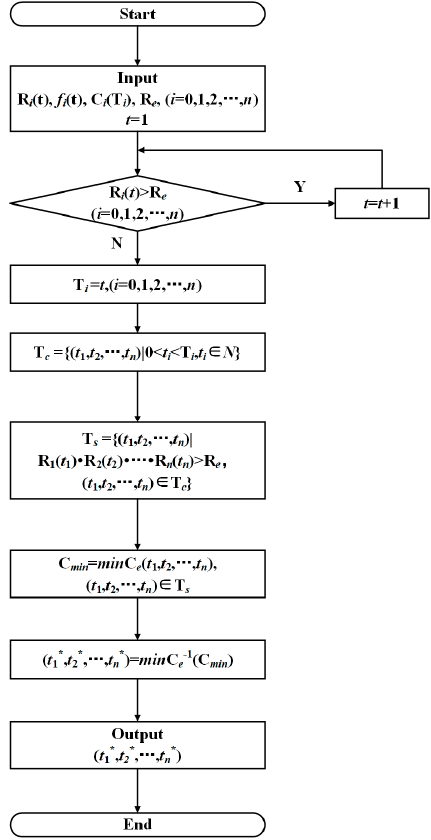
Figure 4. The flow chart for maintenance schedule optimization algorithm.